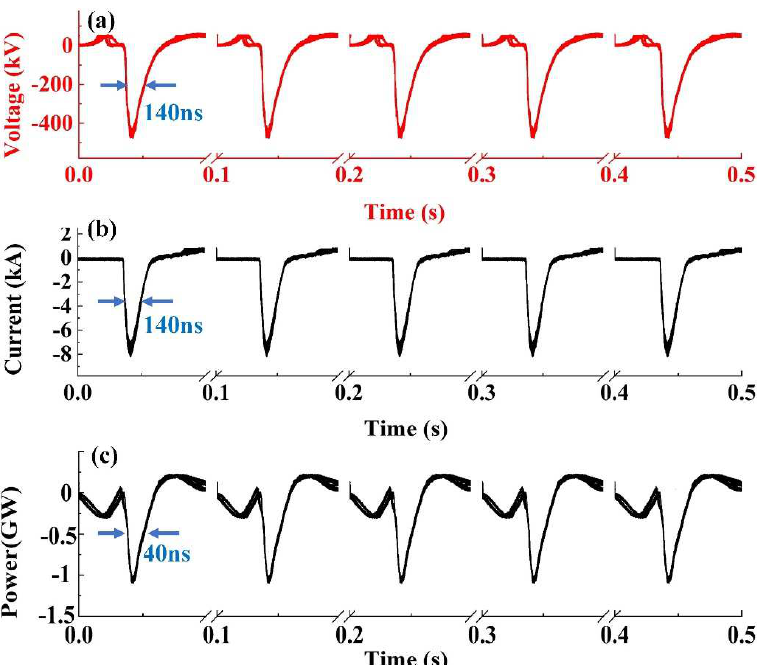
Figure 7. ( a ) Typical diode voltage waveforms, ( b ) current waveforms, and ( c ) microwave wave-